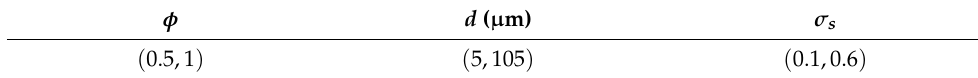
Table 1. Range values of the transport parameters set in GA.